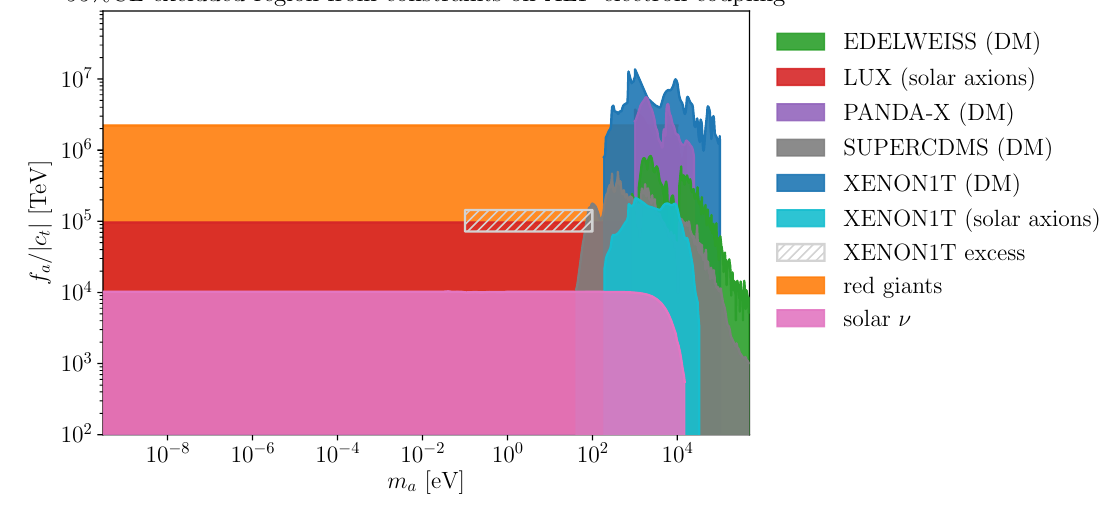
Figure 11 . Limits on f a / | c t | as a function of the ALP mass, extracted rescaling existing constraints on the ALP-electron coupling, taken from ref. [71]. The grey hatched box marks the region roughly compatible with the excess observed by XENON1T